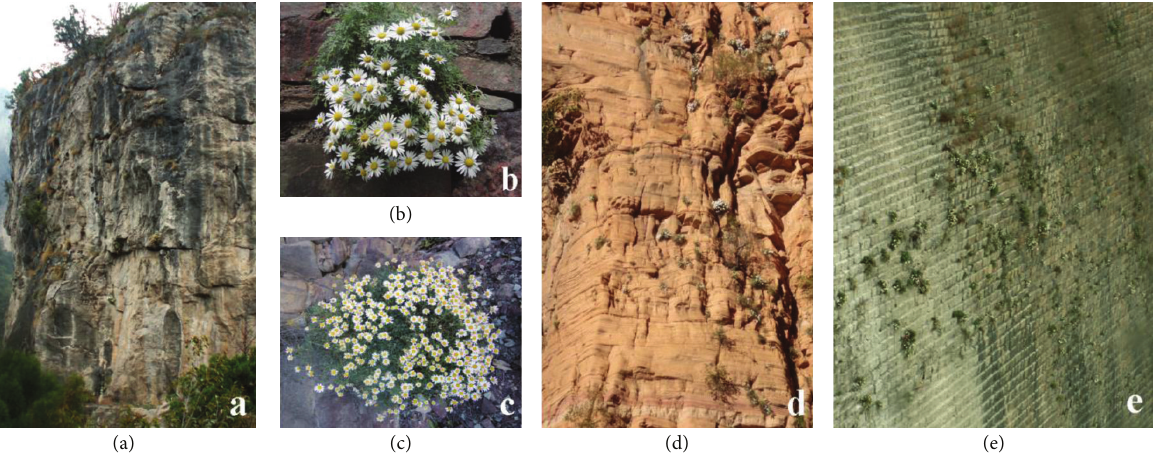
Figure 3: Cliff habitats and flowering plants in Opisthopappus . (a and b) O. taihangensis ; (c and d) O. longilobus ; (e) distributing condition of O. taihangensis in a manmade reservoir dam (more and more plants from the upper to the lower of dam and distribution scope showing triangle) and that reflecting the seed dispersal by wind and gravity.